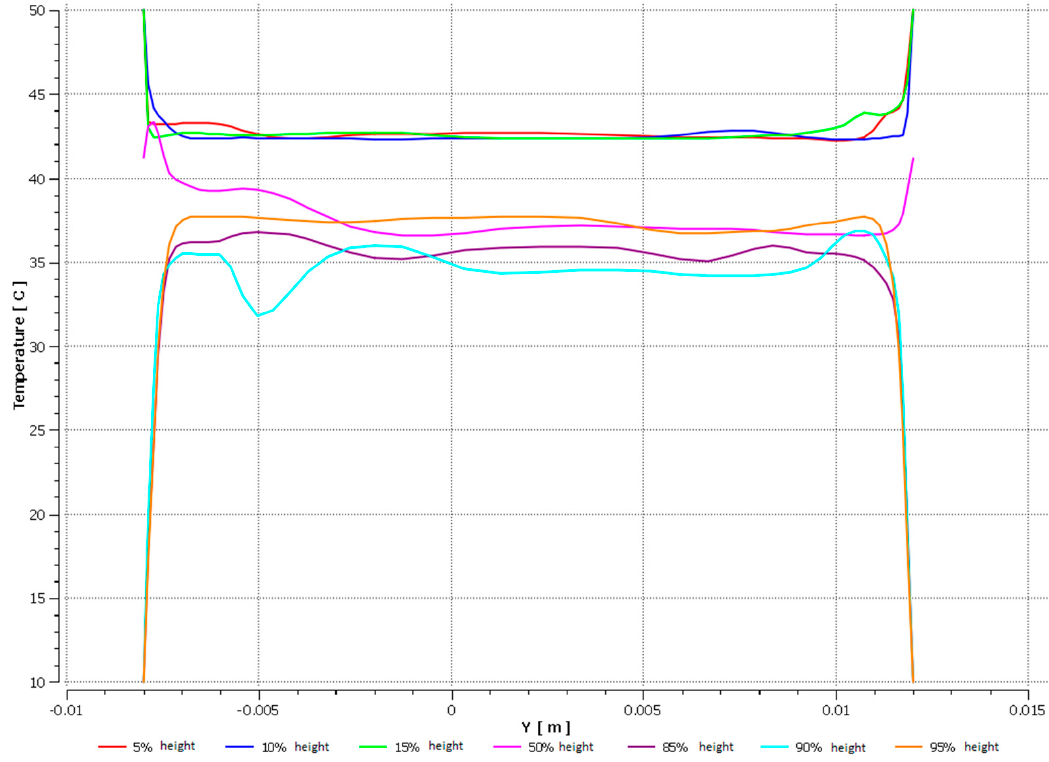
Figure 35. Temperature distribution along the cross-section.